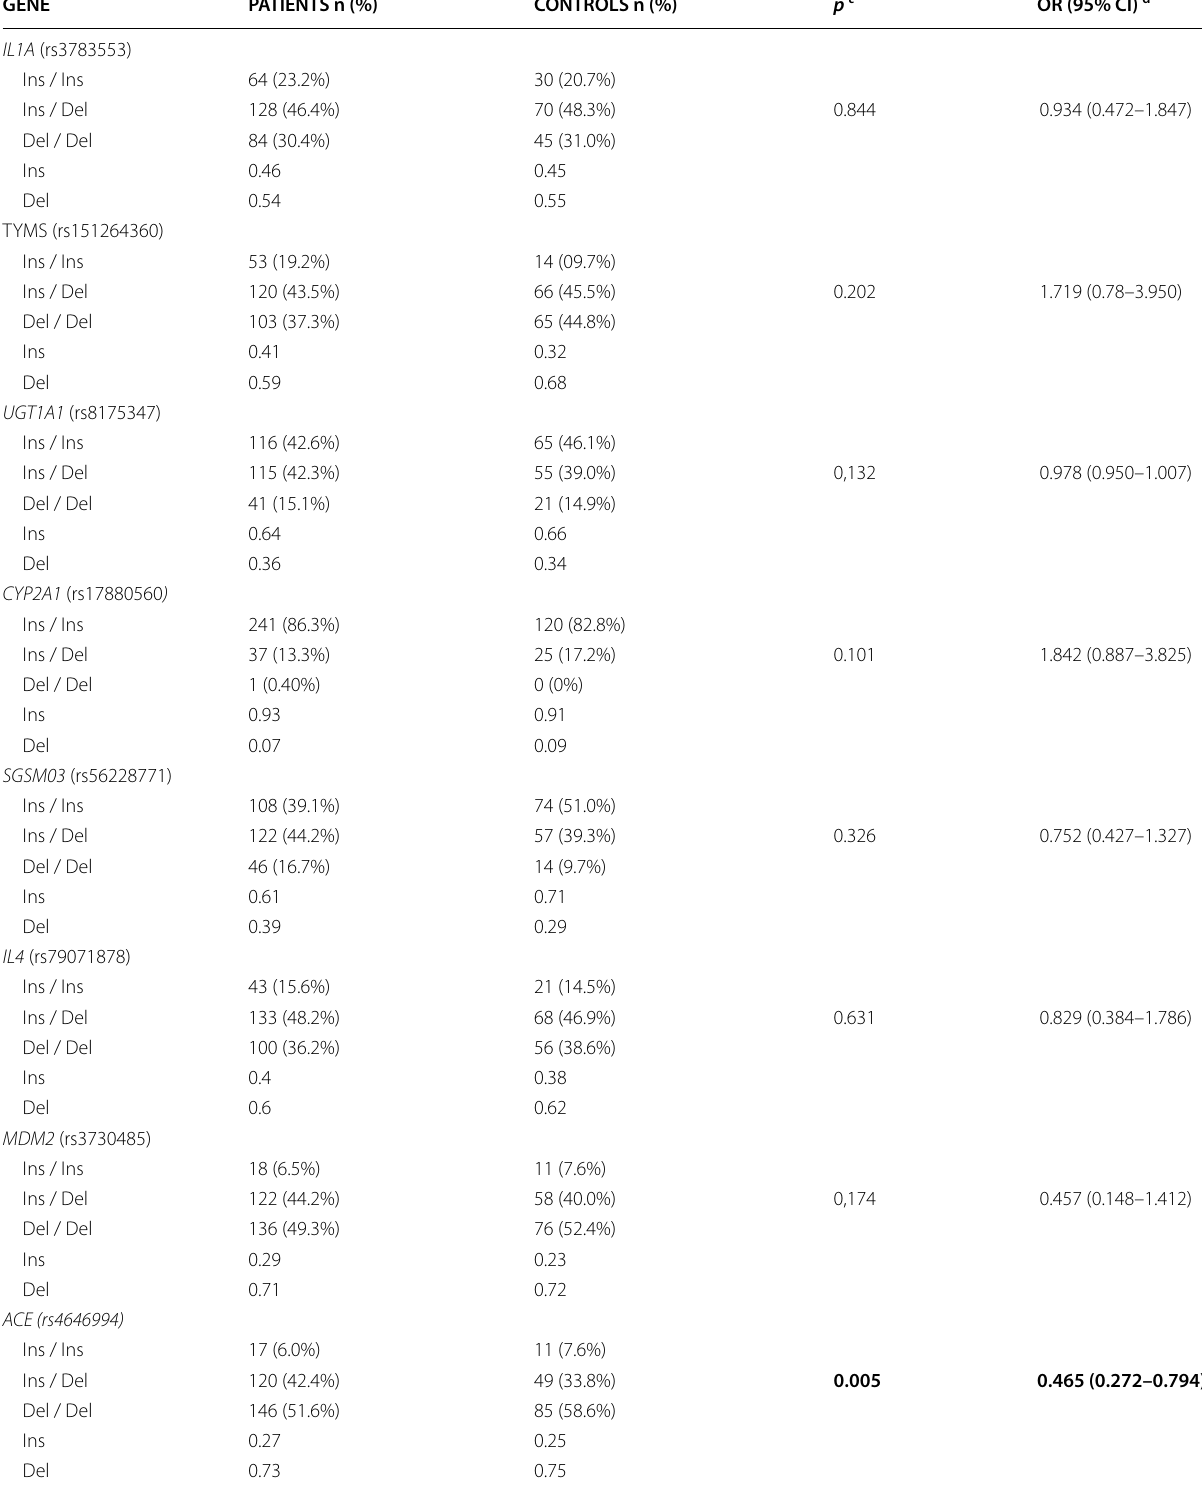
Table 3 Association between groups for the 17 polymorphisms